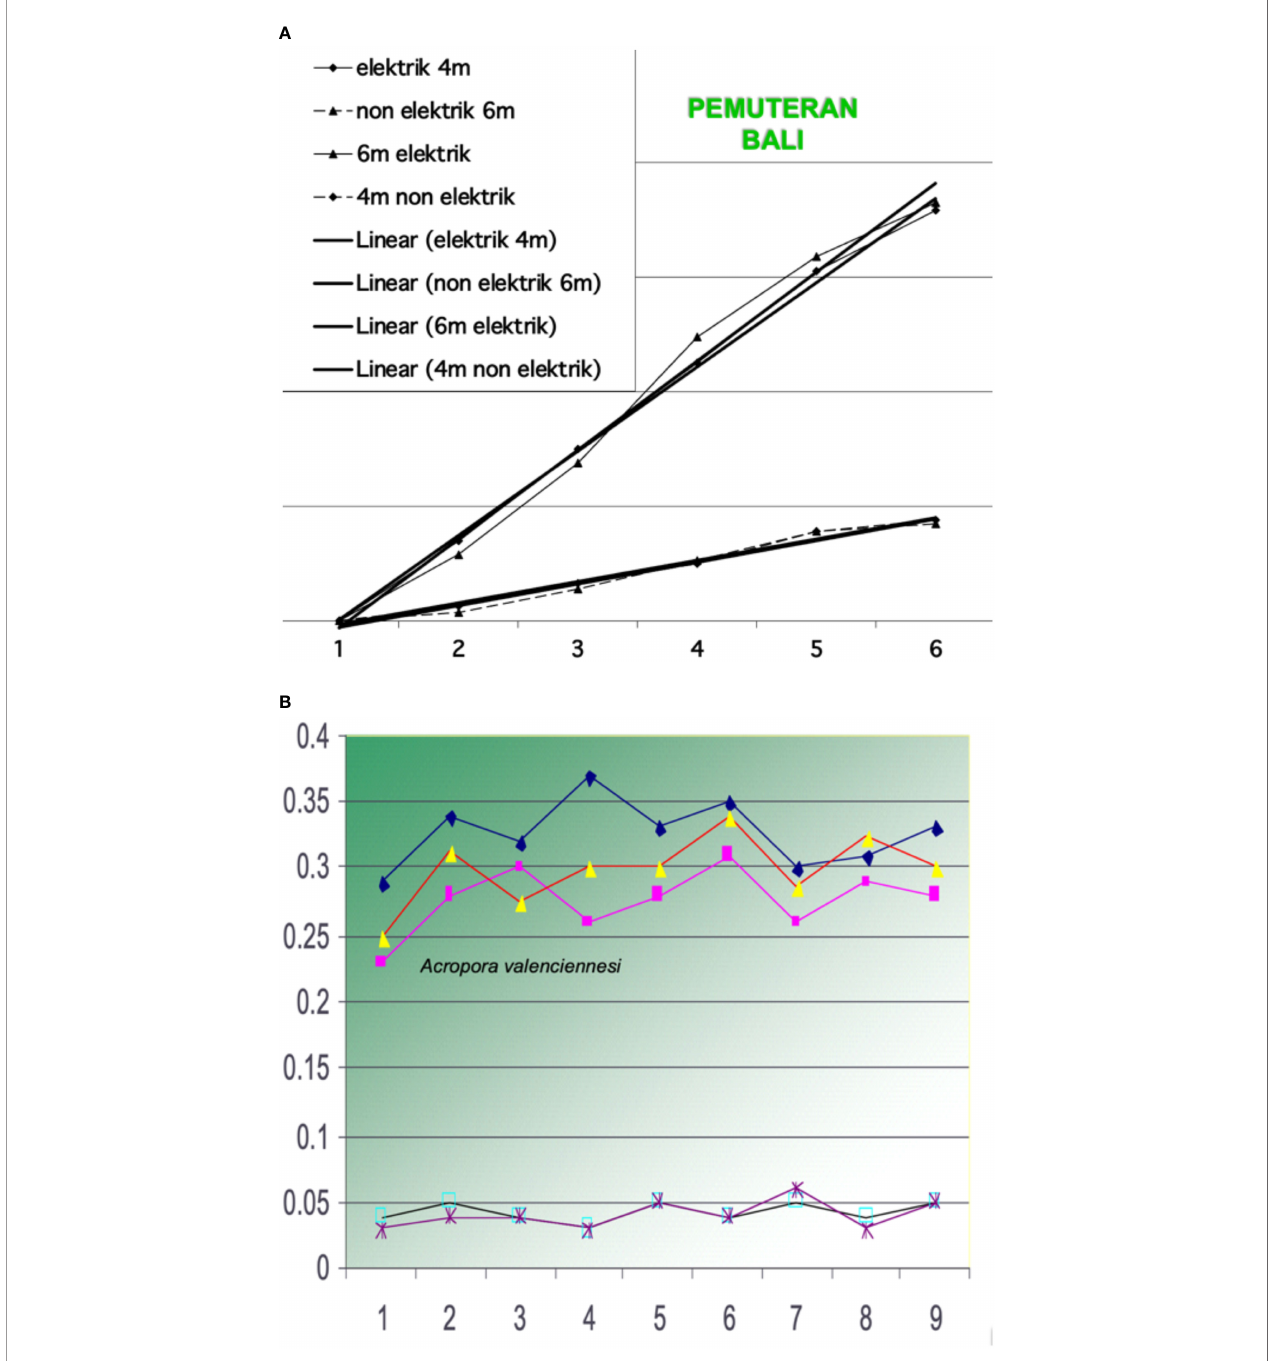
FIGURE 3 | (A) The fi rst measurements of coral growth in Pemuteran, Bali found Biorock corals (top two curves) grew 4.01 times faster than controls (bottom two curves, overlapping). However, it was later realized that this increase was an underestimate because the controls were also in the electrical fi eld even though they were not directly connected to it. Their growth had also been stimulated more than if they had been farther away. The vertical axis is the coral length in centimeters, the horizontal axis is weeks, each data point is the average of 8 corals. Data by Putra Nyoman Dwija, Udayana University, from Jompa et al., 2012. (B) Enhanced growth rate with Biorock (Jompa et al., 2012). Colored symbols on the top three lines are Biorock, x symbols at the bottom are controls. Vertical axis growth rate in centimeters per week, horizontal axis weeks, from Bakti et al.,